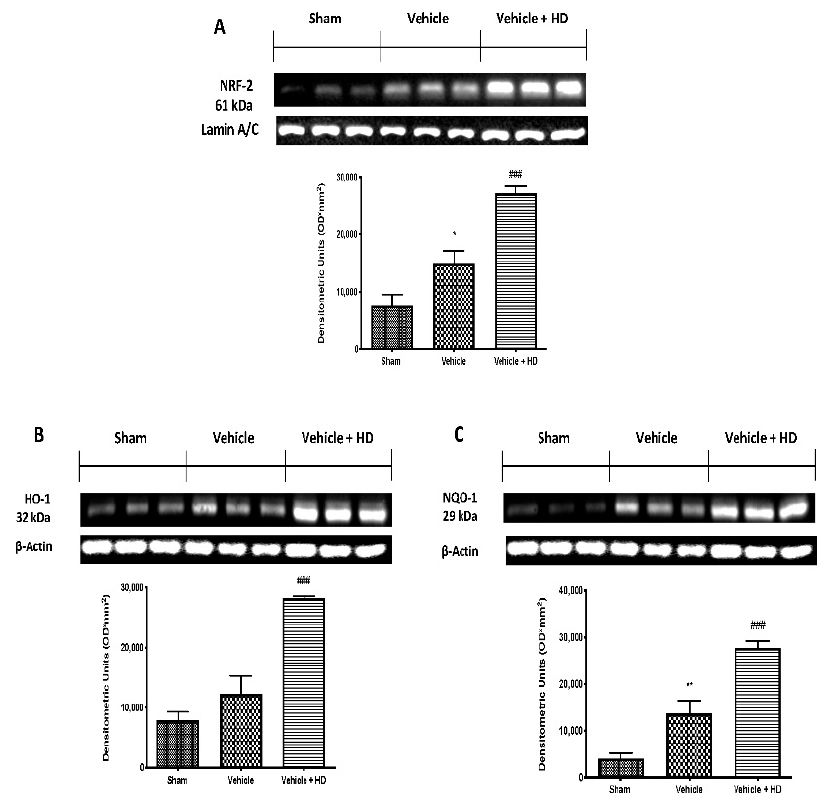
Figure 5. Effect of HD on oxidative stress: Western blot analysis of Nrf2 ( A ), HO-1 ( B ), NQQO-1 ( C ) expression. * p < 0.05 vs. sham; ** p < 0.01 vs. sham; ### p < 0.001 vs. vehicle.